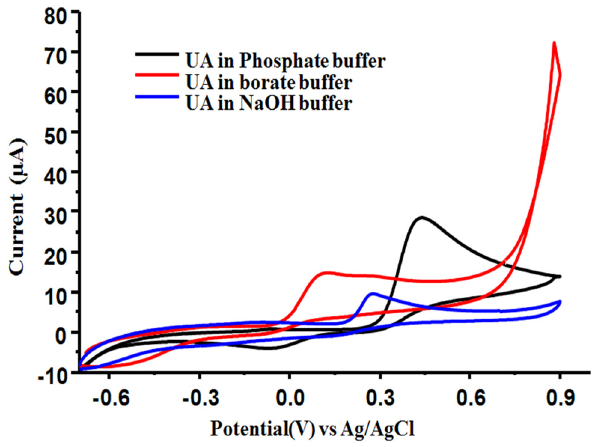
Figure 4: CV response of di ff erent supporting electrolytes; black line shows 0.1 M PBS pH ( 7.4 ) , the red line shows 0.1 M borate pH ( 9 ) , and the blue line shows 0.1 M NaOH pH ( 12 ) .